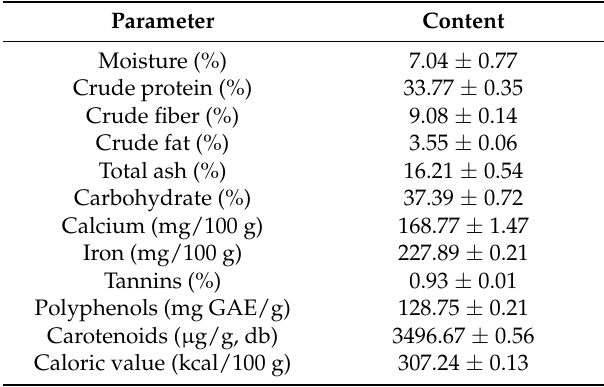
Table 2. Chemical composition of nettle leaf powders